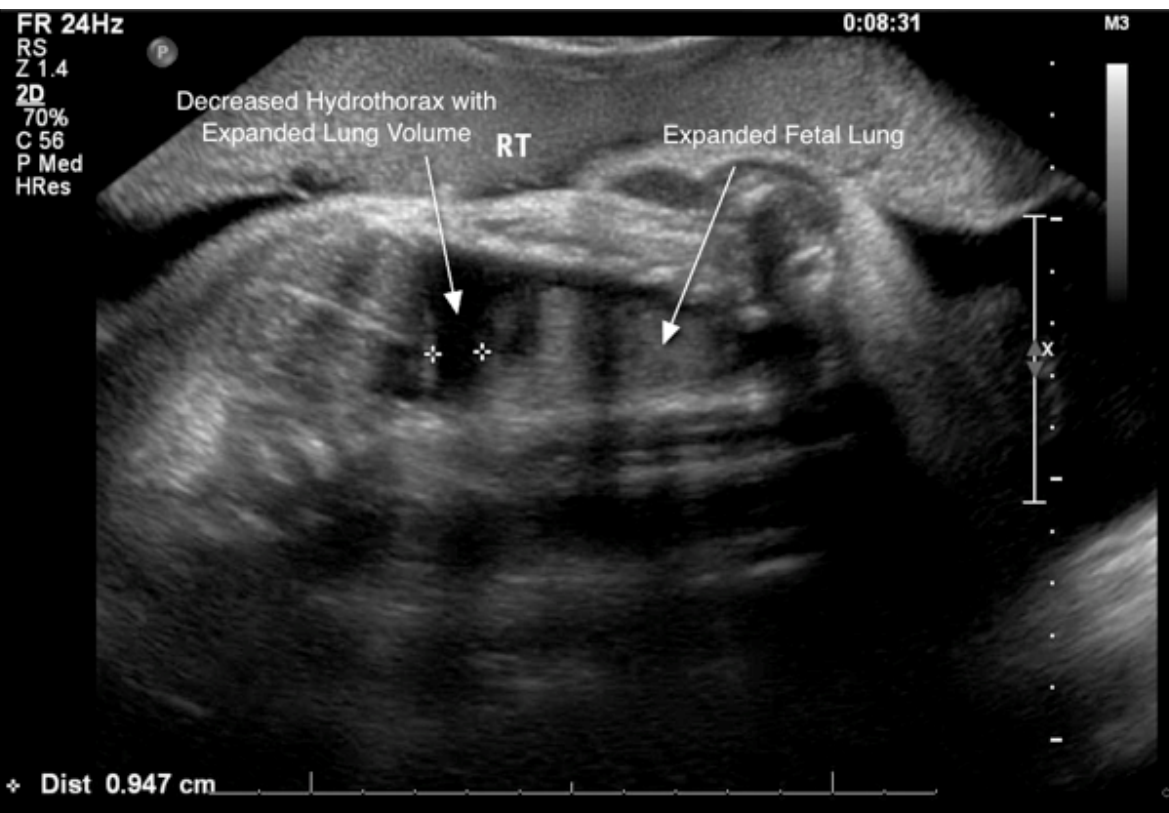
FIGURE 2. Follow-up fetal ultrasound at 32 weeks. Hydrops fetalis has resolved and expansion of the fetal lung can be seen (right arrow). Residual fetal hydrothorax is decreased in size (left